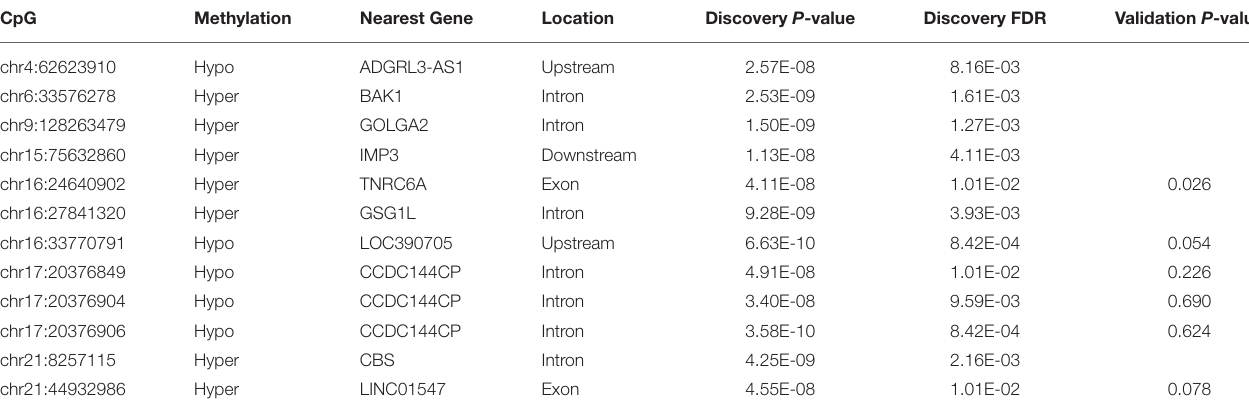
TABLE 2 | CpGs Associated with POAF. CpG Methylation Nearest Gene